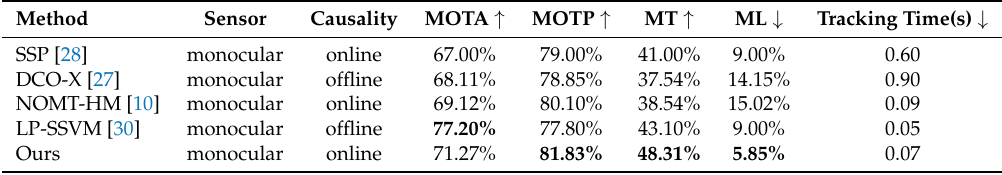
Table 4. Comparison with state-of-the-art methods on the testing subset of KITTI